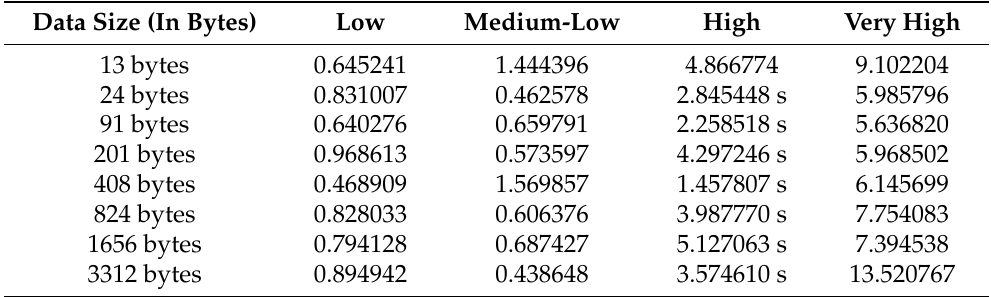
Table 4. Temporal behaviour as the exchanged data size and the request bursts increase (in